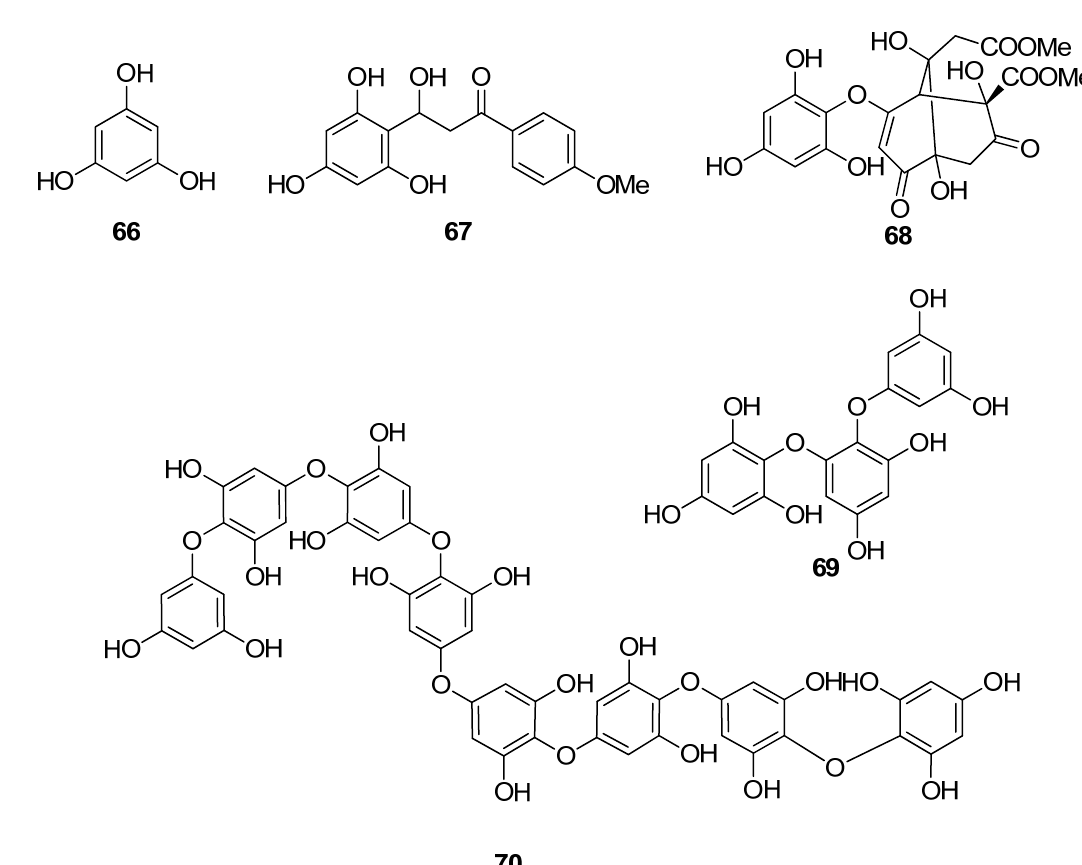
Figure 5. Chemical structures of compounds 66 – 70 .